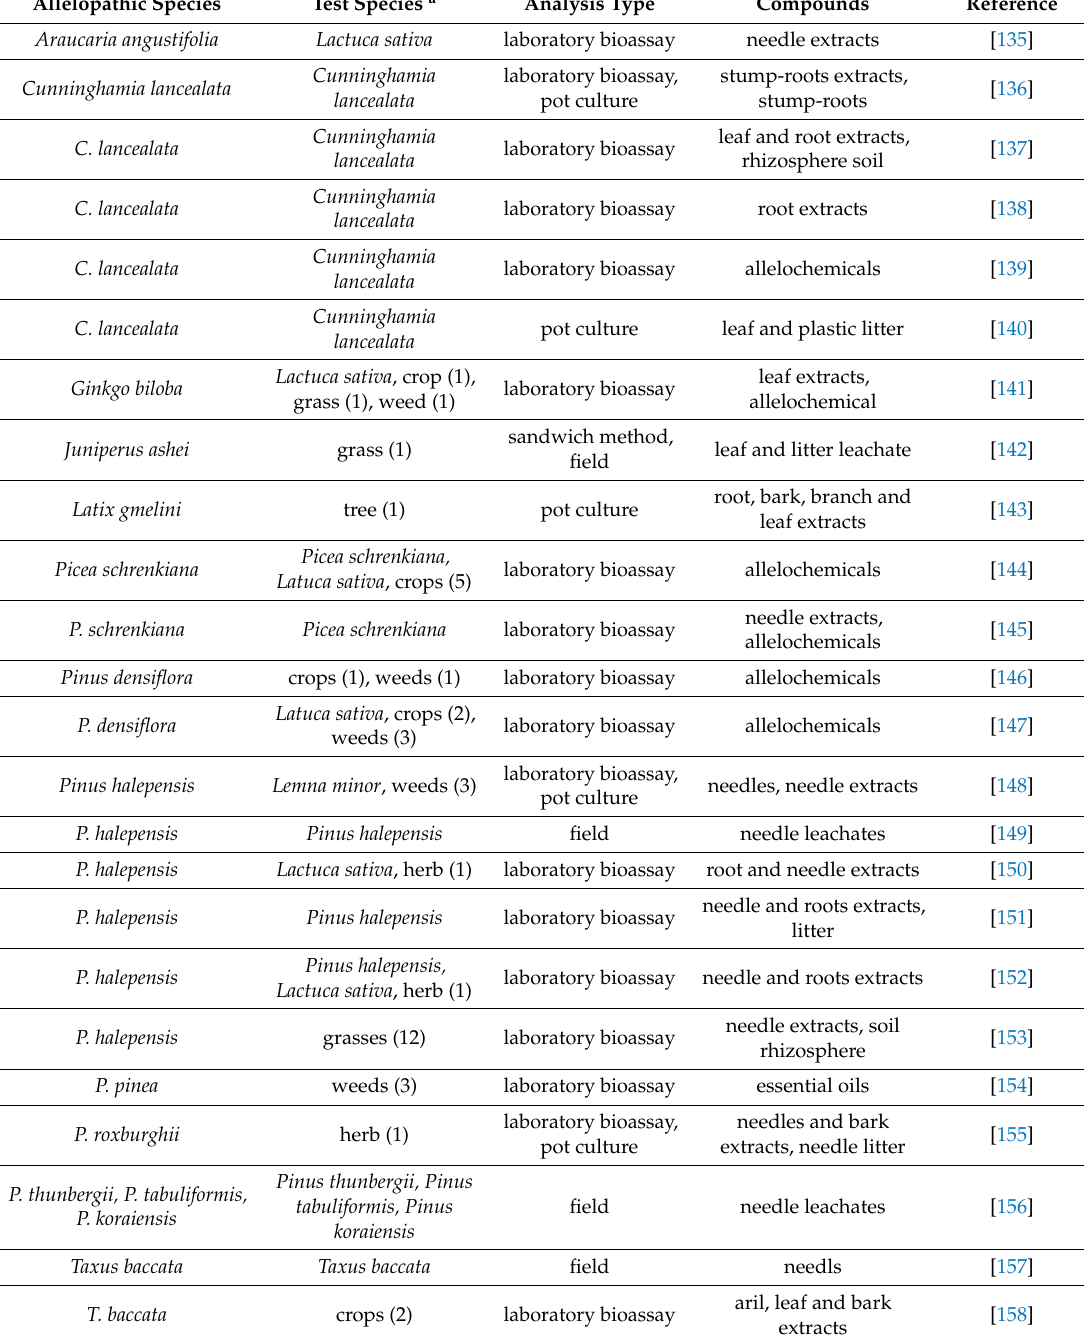
Table 2. Allelopathy of gymnosperm